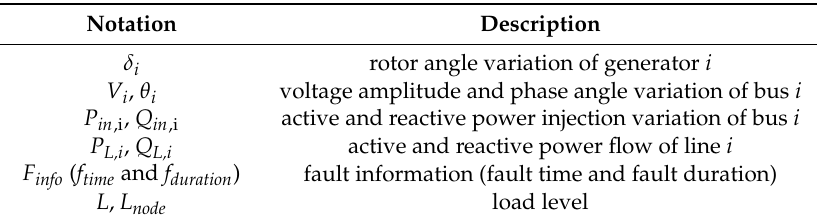
Table 1. Initial features for Fisher discrimination